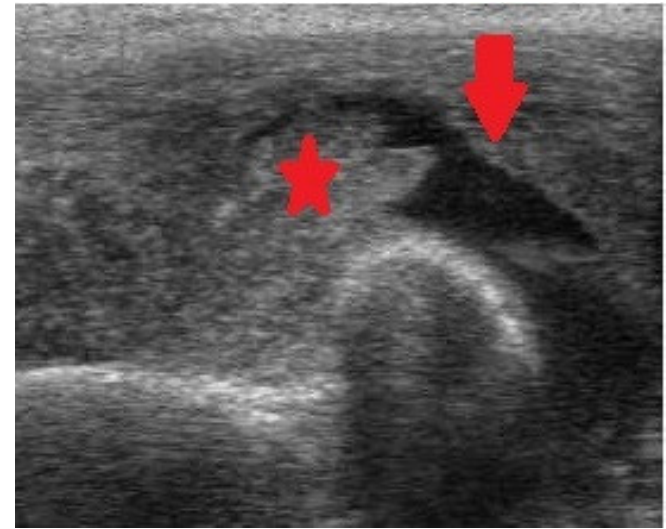
Figure 4. Ultrasonography (US) of the elbow exhibiting intraarticular fluid (arrow) and intense synovial enlargement (asterisk).